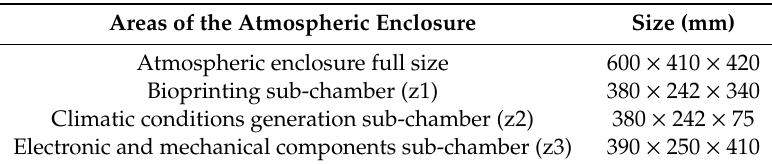
Table 1. Atmospheric enclosure dimensions.